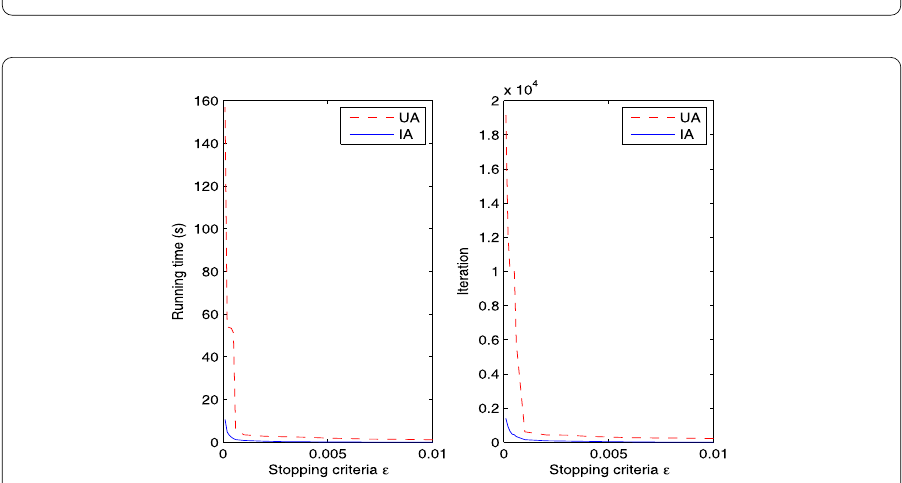
Figure 2 The comparison of running time and iteration steps of inertial acceleration (IA) and without inertial acceleration (UA) with the same stopping criteria for ( M , N ) = (100,1000) of Example 4.1